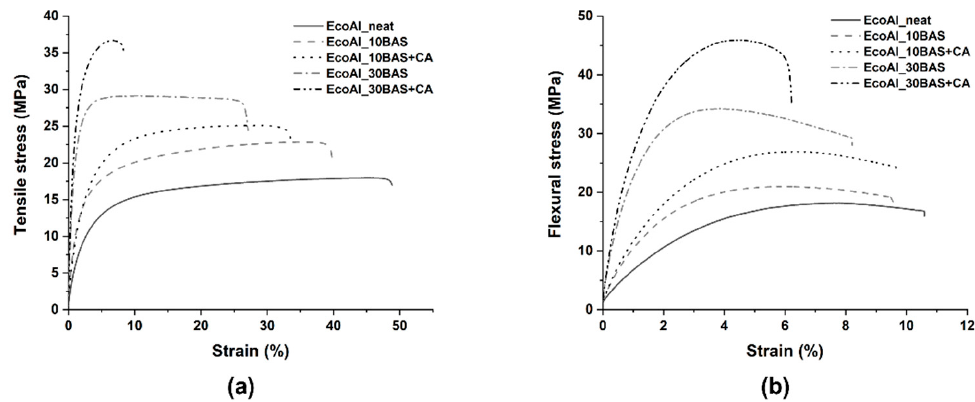
Figure 3. Representative ( a ) tensile and ( b ) three-point bending curves of EcoAllene-based composites. Table 4. Tensile and flexural properties of EcoAllene-based composites.